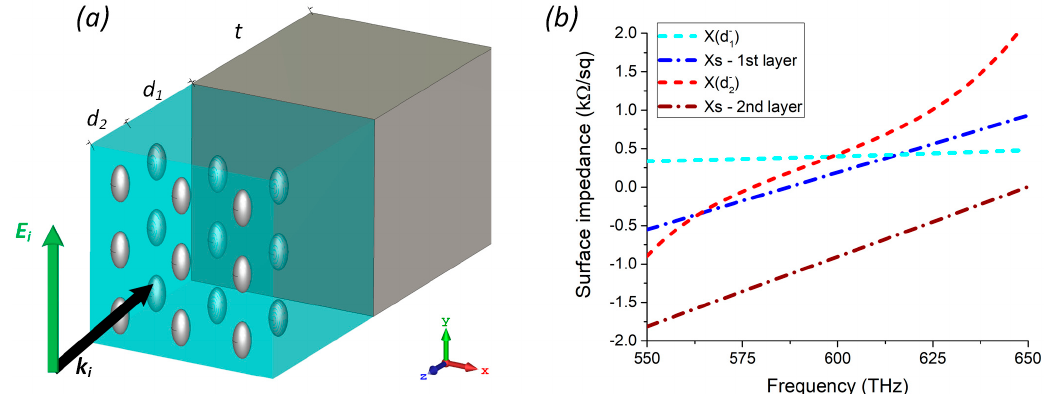
Figure 3. ( a ) The two-layered optical circuit-analogue (CA) absorber. The ground plane is replaced by a thick enough layer of silver; ( b ) the surface reactance of the two metasurfaces required to maximize the absorption within the frequencies range 550–650 THz. The surface reactances of the metasurfaces are compared with the input reactance of the absorber evaluated before the first and the second layer.